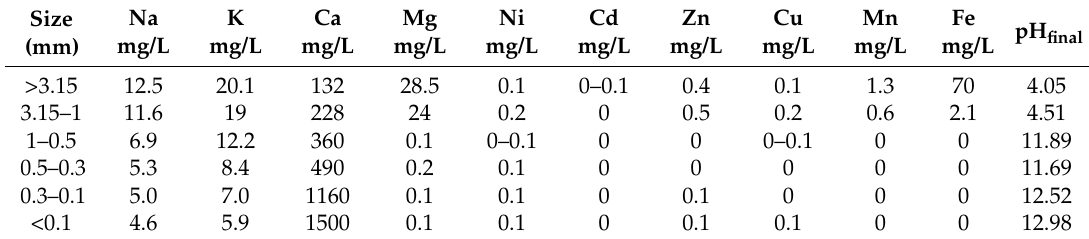
Table 4. Leachate analysis of different particle size.